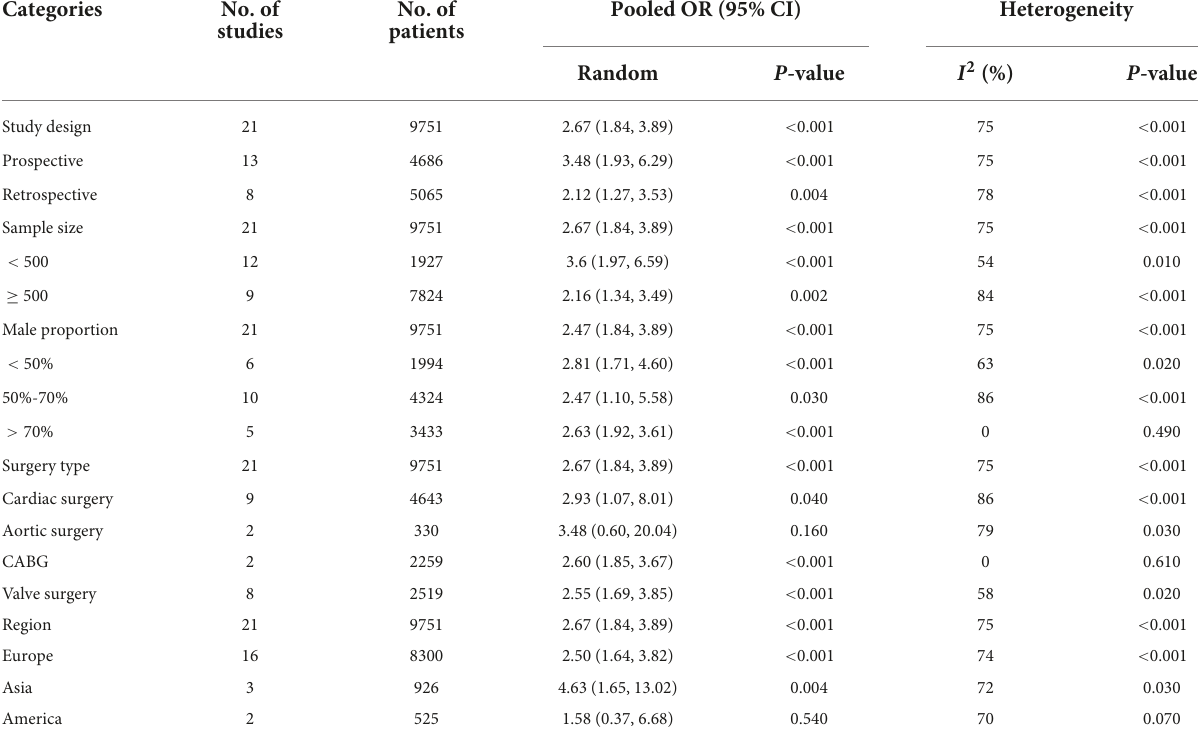
TABLE 3 Subgroup analysis of pooled OR for